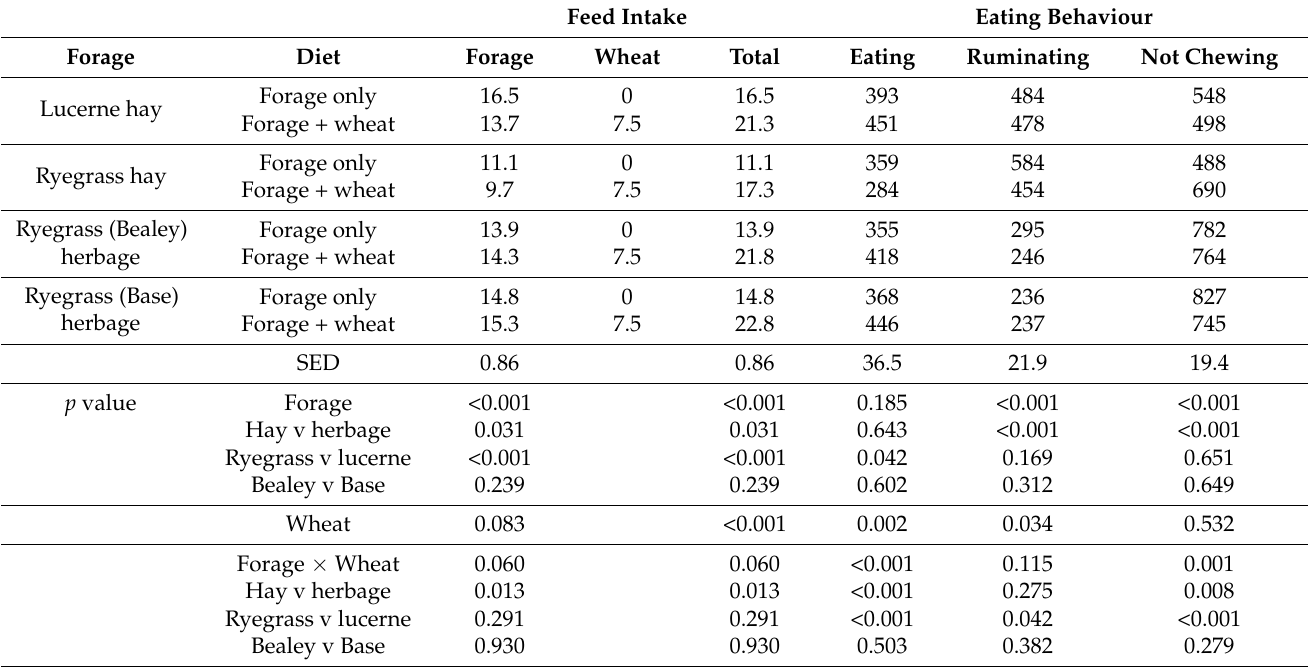
Table 2. Influence of forage type and the addition of wheat to the diet on feed intake (kg DM/cow day − 1 ) and eating behaviour (min/cow day − 1 ) 1 . Feed